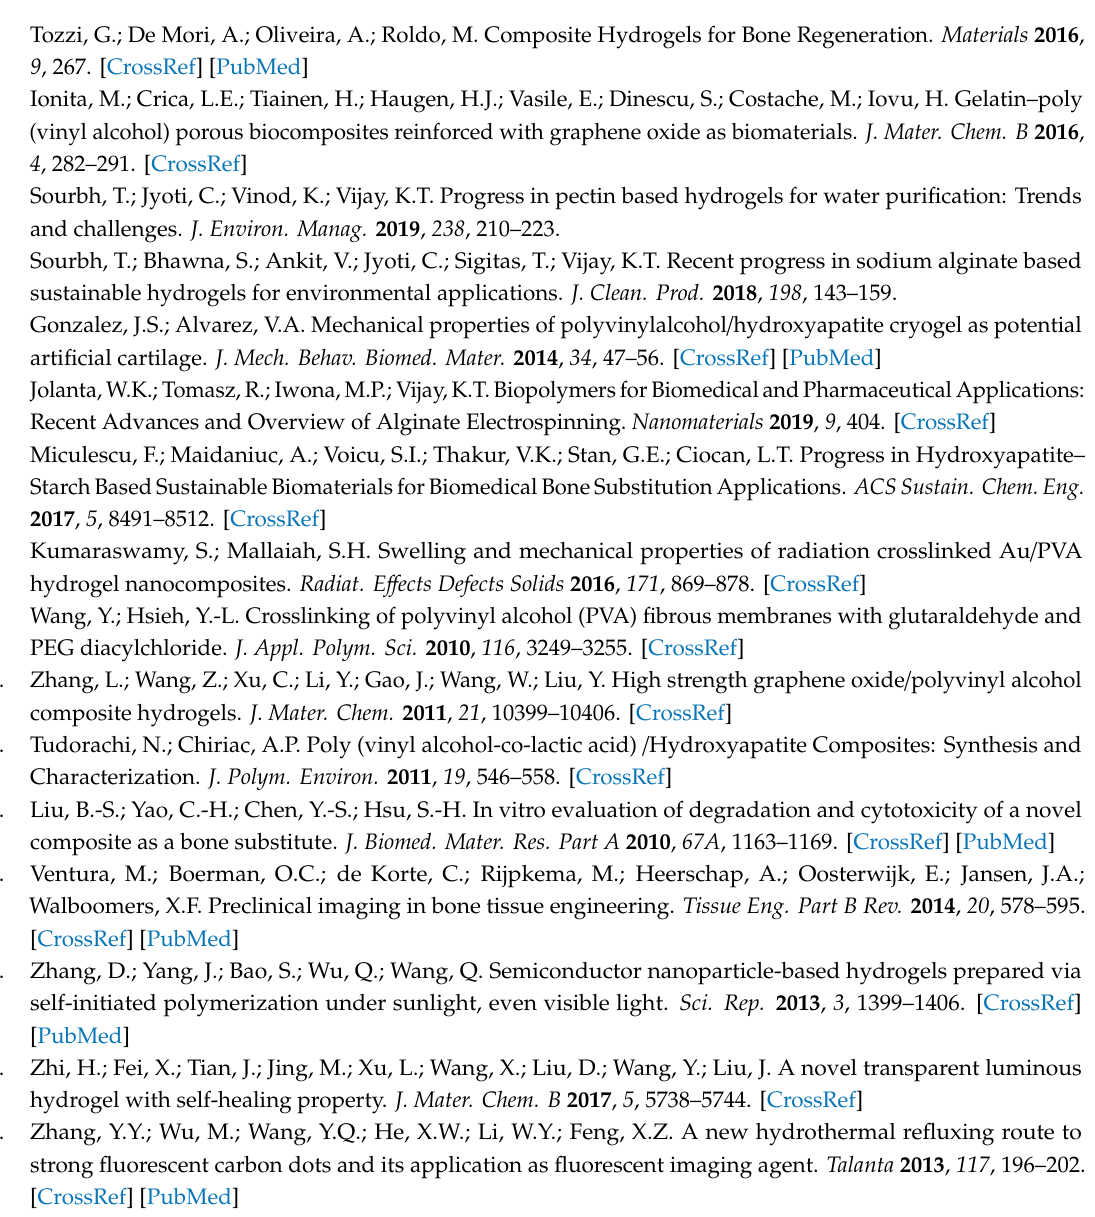
Table S1. The mechanical properties of the CDs / HA / PVA SN hydrogels with various proportions. Figure S1. (a) the fluorescence excitation and emission spectroscopy of the as-prepared CDs and (b) fluorescence emission spectroscopy of the CDs / HA 0.6 / PVA SN hydrogels with mass ratios of CDs to PVA at 0.0%, 0.6%, 0.9% and 1.2%, respectively ( λ ex = 300